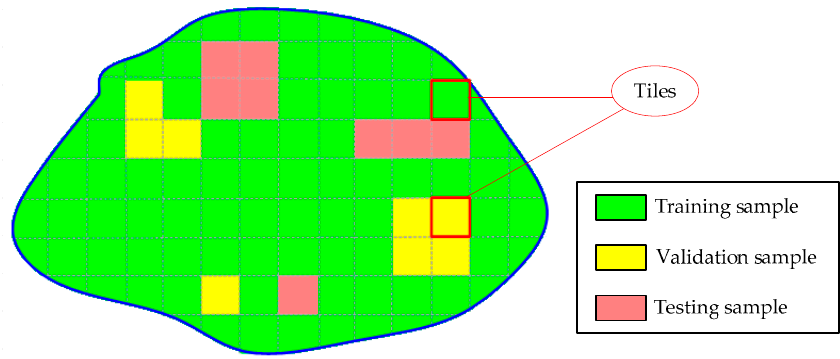
Figure 5. Tile-based samples selection and partition, where each type of sample consists of several tiles.